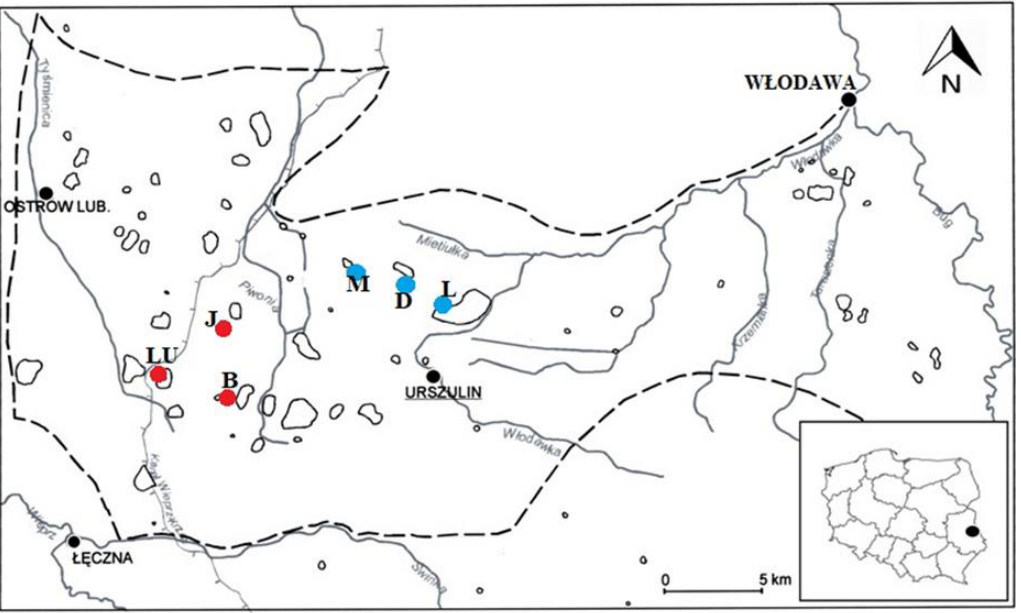
Figure 2. Location of water and plant material sampling stands: LU—Łukietek, J—Jelino, B—Brzeziczno, M—Moszne, D—Długie, L—Łukie. Blue dots—the location of natural aldrovanda sites, Red dots—sites where reintroduction of the species is planned, Black dots—location of villages and towns.